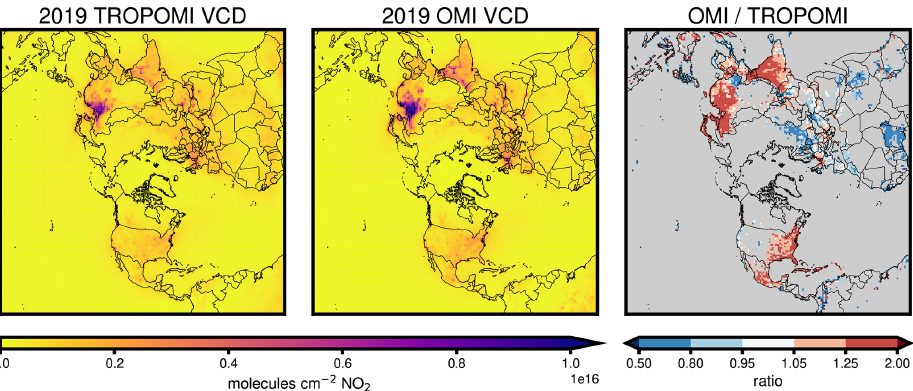
Figure 2. 2019 annual average TROPOMI and OMI vertical NO 2 vertical column densities, with CMAQ NO 2 profiles applied, and the ratio between them. Column density ratios are only shown for the grid cells where NO x emissions updates are applied in the emissions